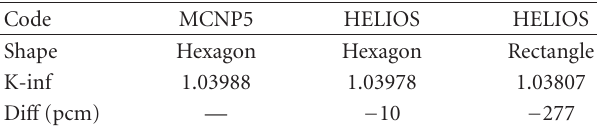
Table 2: CNA-I idealized lattice results.